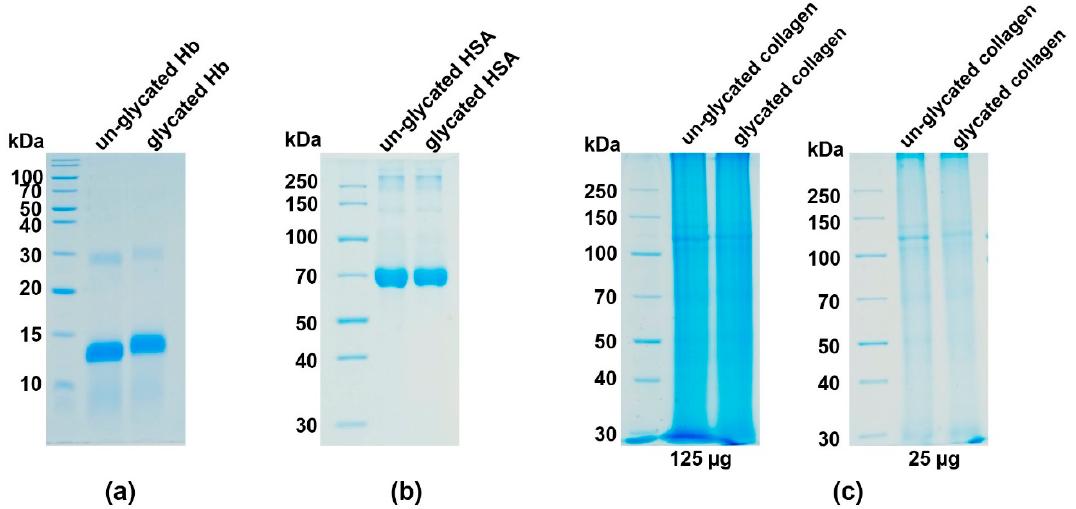
Figure 1. Analysis of glycation efficiency. Glycation of ( a ) hemoglobin, ( b ) albumin and ( c ) collagen was examined using SDS-PAGE and CBB G-250 staining. Verification of collagen glycation was carried out using samples containing 125 or 25 µg protein. Hb, hemoglobin; HSA, human serum albumin.